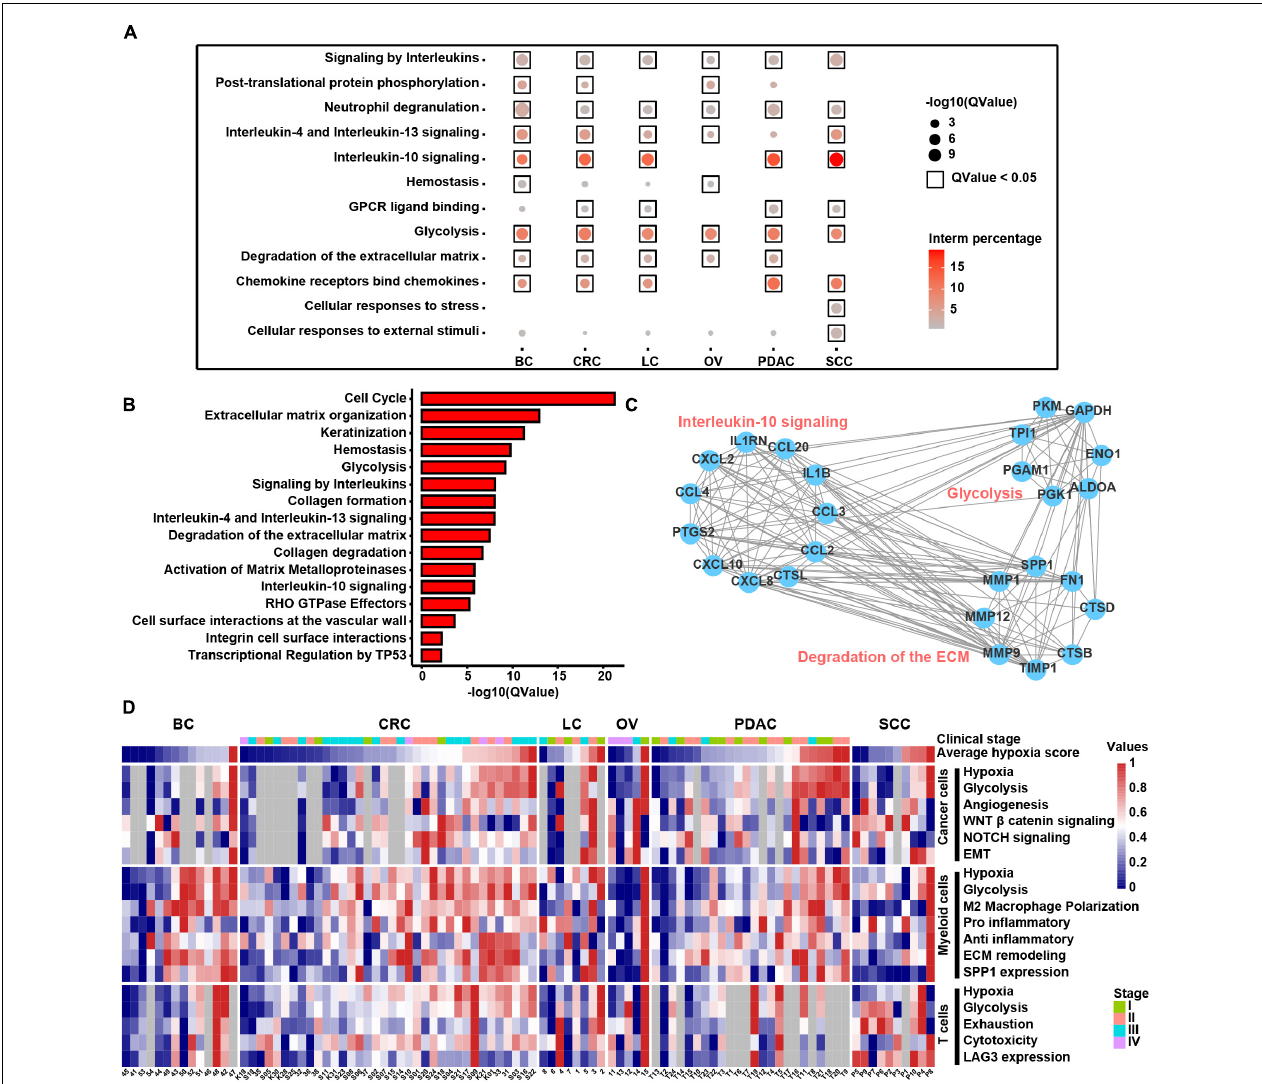
FIGURE 7 | Molecular characteristics of different cell types across samples under the hypoxia TME. (A) Enriched Reactome gene sets of upregulated genes in hypoxia-high myeloid cells across six cancer types. (B) Enriched Reactome gene sets of upregulated genes in hypoxia-high samples at least in 13 TCGA cancer types. (C) The protein–protein interactions among differentially expressed genes (DEGs) upregulated in hypoxia-high myeloid cells. (D) Clustered heatmap of 18 features across pan-cancer samples. Samples are arranged from low hypoxia score to high hypoxia score with the color blue to red, respectively. For tumors, the stage is indicated by color. Gray rectangles highlight that there were less than 50 cells in this sample. The values were normalized from 0 to 1 by